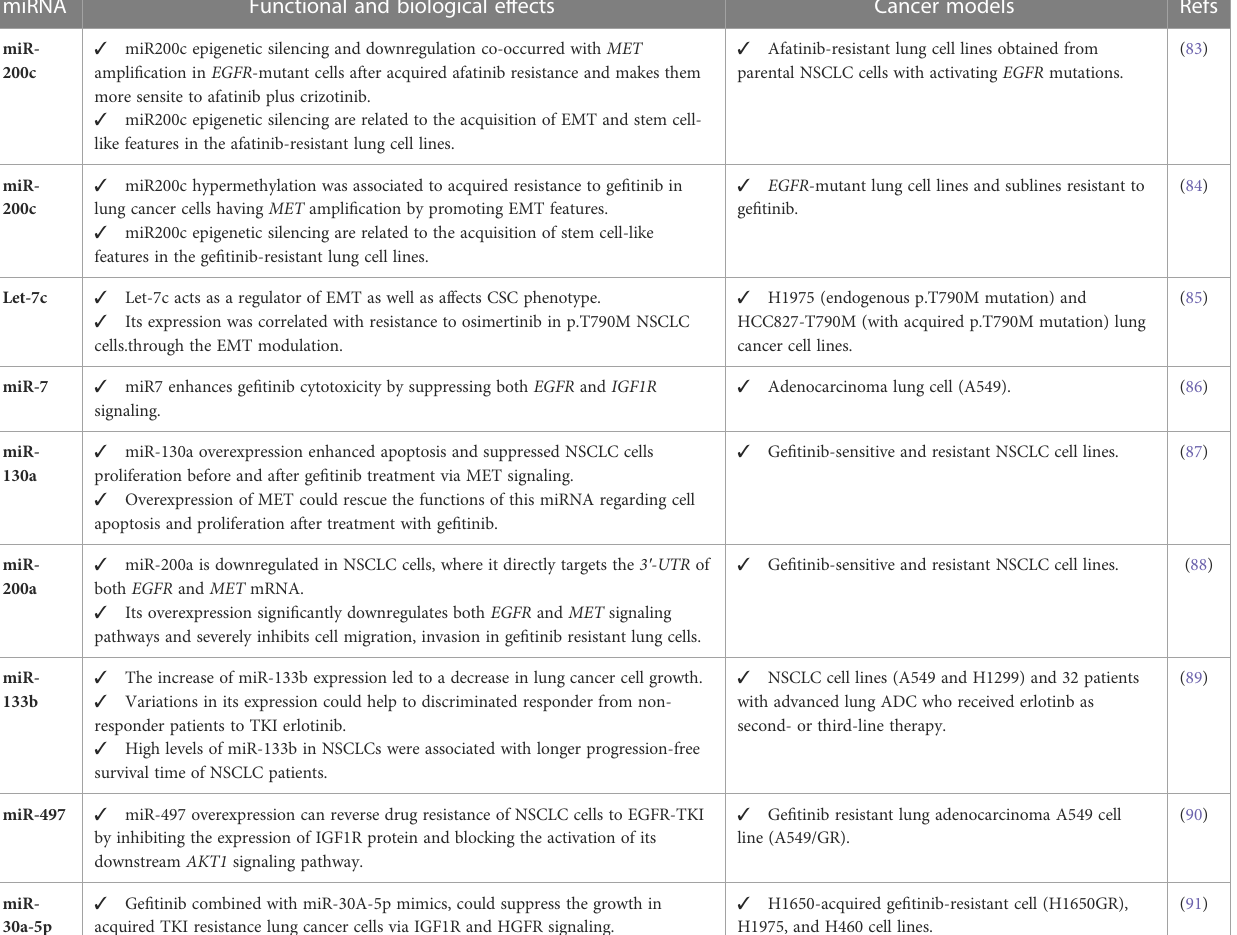
TABLE 2 Functional and biological role of miRNAs related to EGFR-TKI resistance in lung cancer models. miRNA Functional and biological effects Cancer models